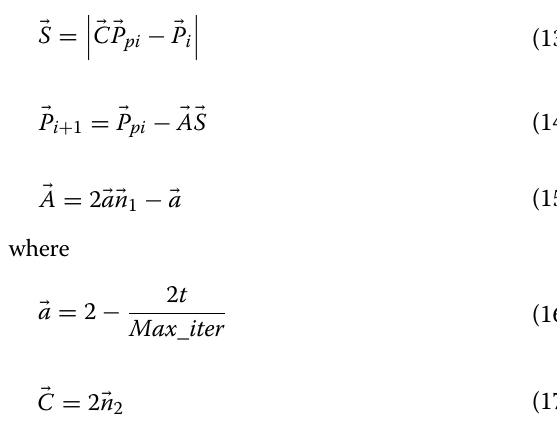
decision. The omega (ω) is considered the lowest posi- tion wolf, which acts as the scapegoat. The rest of the wolves are called delta (δ), and all of the deltas follow alphas and betas. All of these roles are presented in Fig. 3. The GWO method has three main steps to reach a prey: (i) search for the prey and approach it, (ii) sur- round the prey and limit its motion, and (iii) attack and hunt down the prey. The surrounding of the prey can be presented in arith- (cid:31) P metic form as in (13), where i is the position of the GW, (cid:31) S (cid:31) P is the distance between pi is the position of prey, and (cid:31) A (cid:31) C them. and are vectors that are computed from Eqs. (15)–(17).